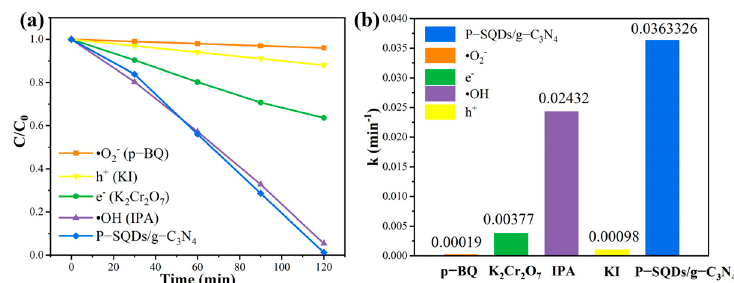
Figure 7. ( a ) Effect of scavengers on the catalytic effect of P-SQD/g-C 3 N 4 . ( b ) The reaction rate of P- SQD/g-C 3 N 4 in trapping experiments under visible light irradiation.